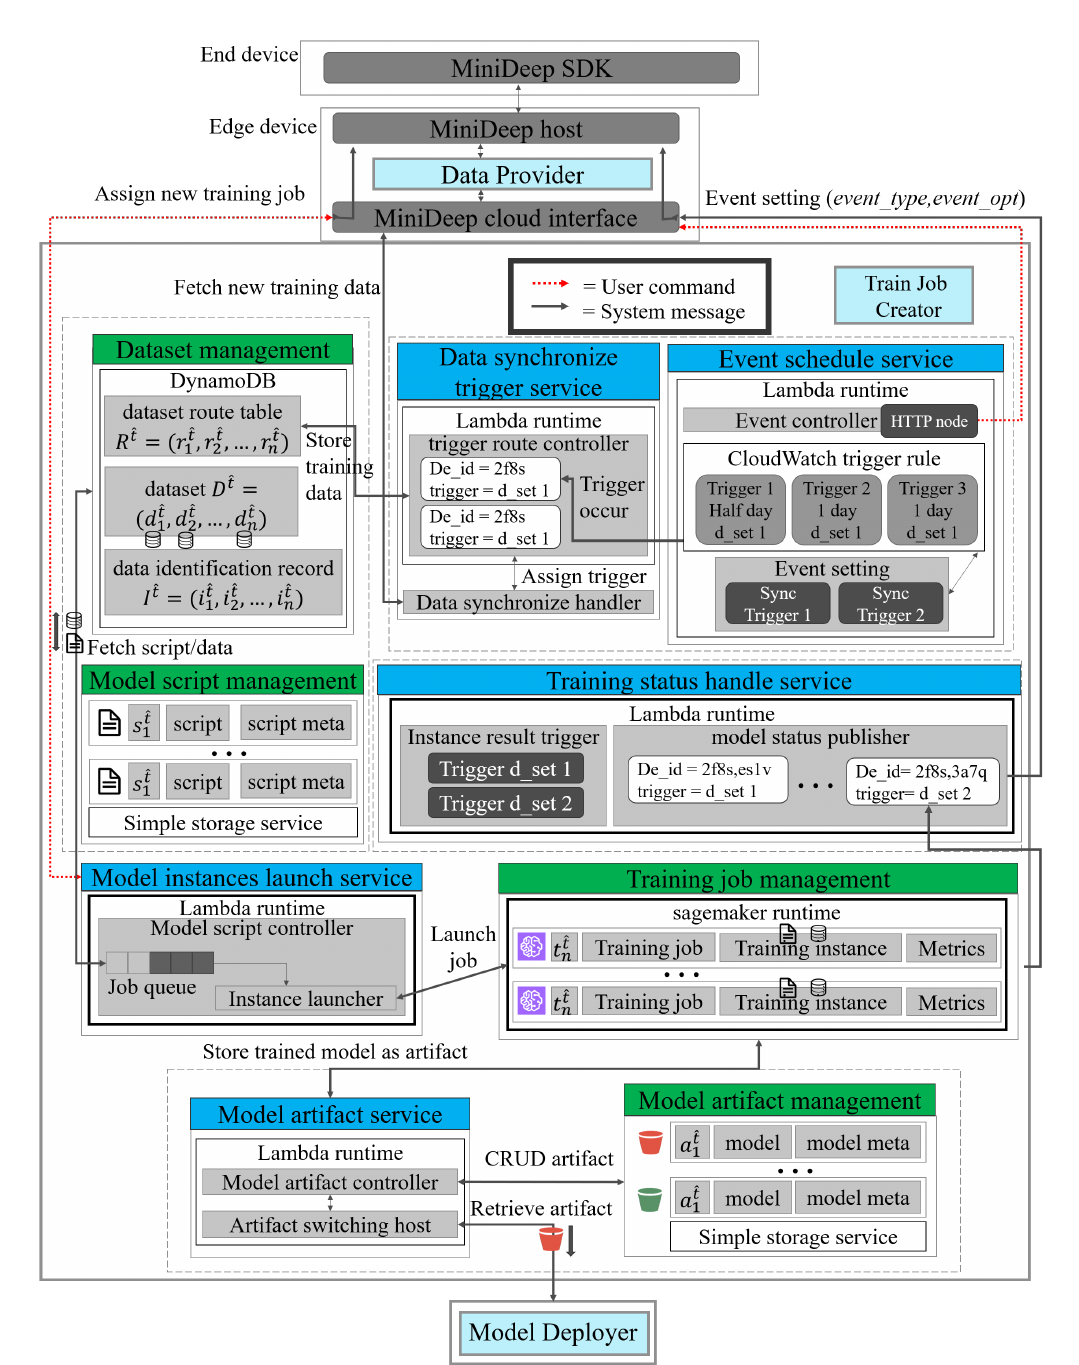
Figure 4. The detailed functions of the Train Job